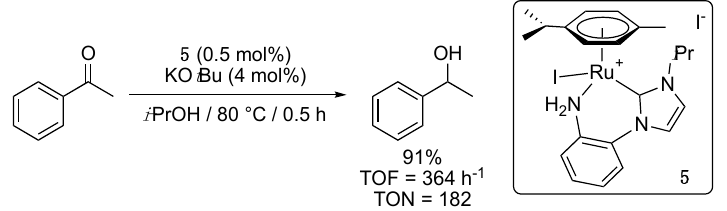
Scheme 5. TH of acetophenone catalyzed by the amino-functionalized NHC-Ru(II) complex 5